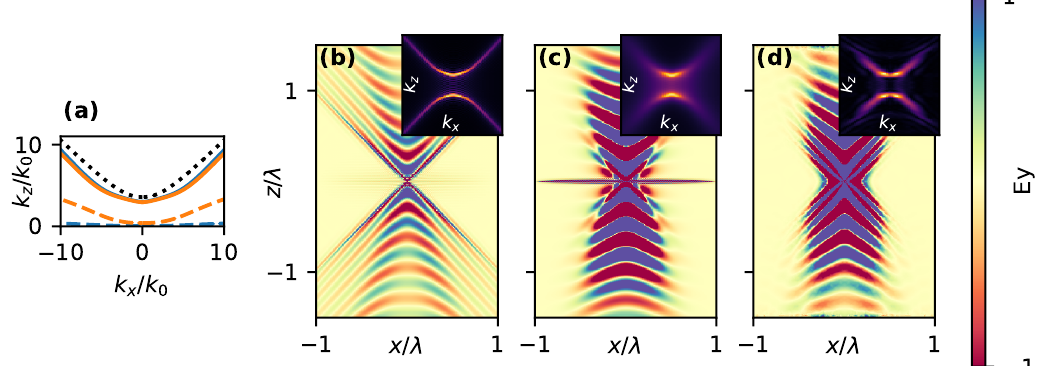
Figure 3. ( a ) Real and imaginary parts of the propagation constant k z for the odd mode in the three layer system (details in the text) for losses γ = 0.01 (blue) and γ = 0.1 (orange). Dotted black line indicates corresponding dispersion of single interface. ( b , c ) Semi-analytically calculated field profiles for losses γ = 0.01 ( b ) and γ = 0.1 ( c ). ( d ) Full-wave simulations of the field profile for losses γ = 0.1. Insets show Fourier transformed fields, showing dispersion of the propagating waves.